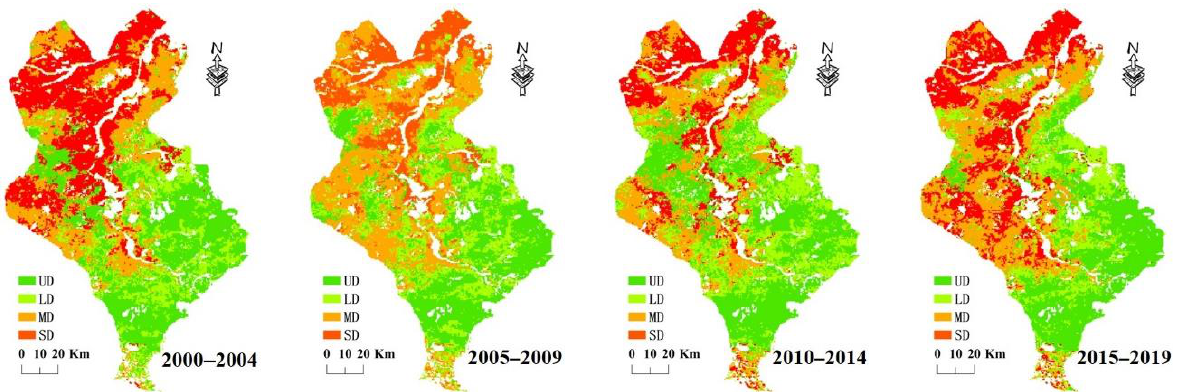
Figure 3. Spatial distribution of grassland degradation in the study area, from 2000 to 2019. UD, undegraded grassland; LD, lightly degraded grassland; MD, moderately degraded grassland; SD, severely degraded grassland.